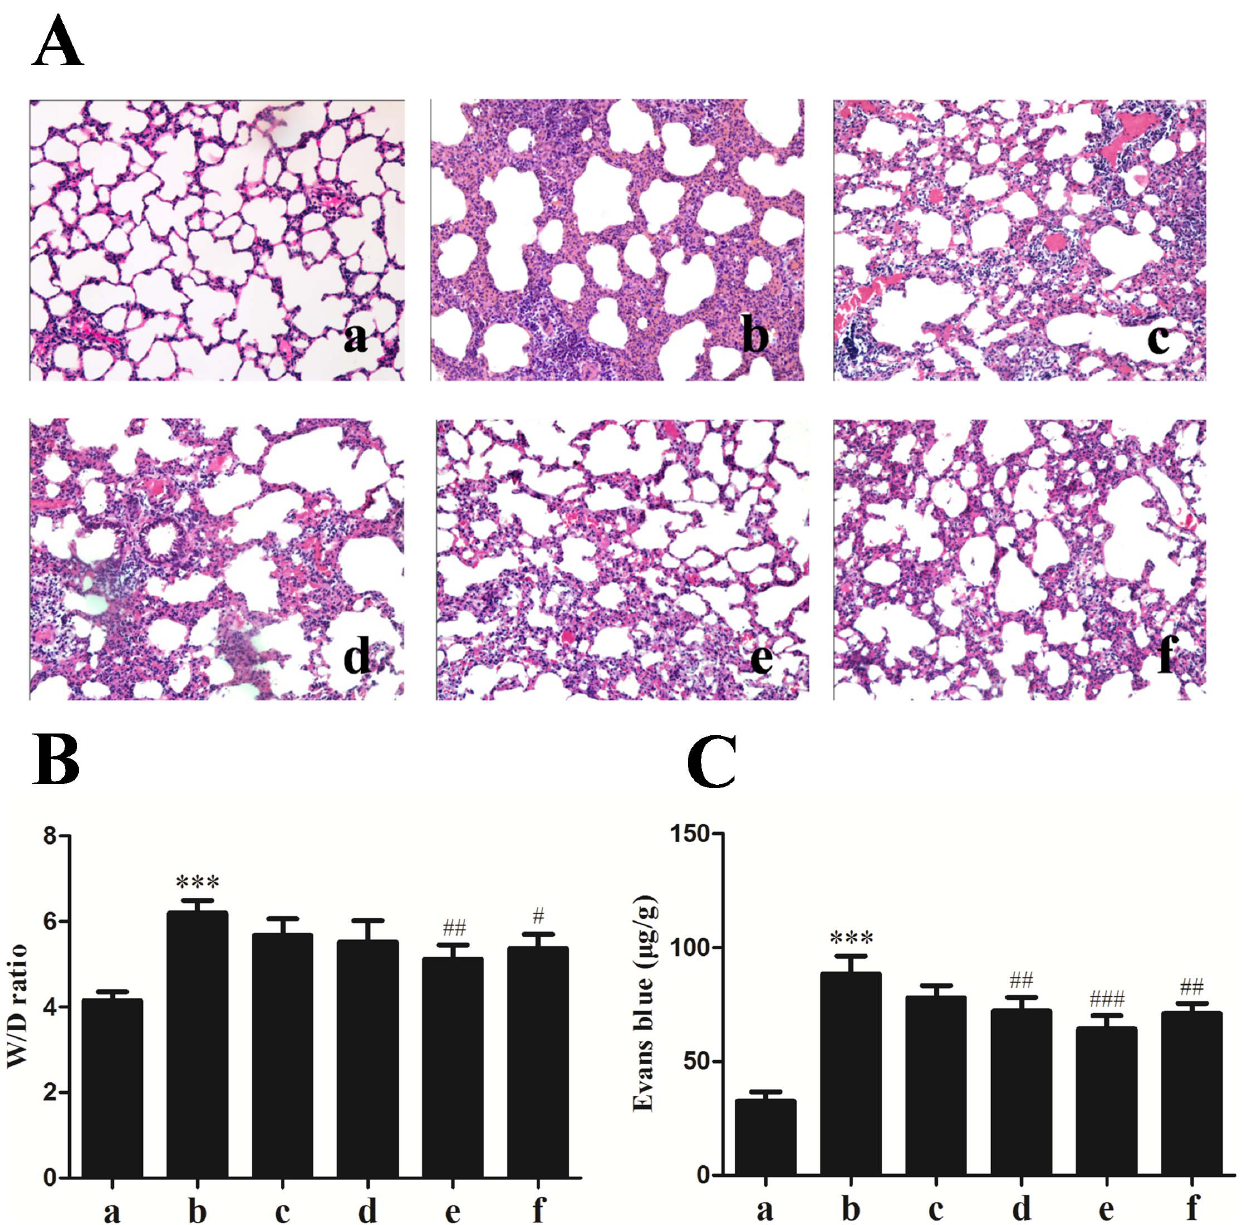
Figure 1. Effects of calcitriol on seawater aspiration-induced lung histopathologic changes (A), wet/dry weight ratios (B) and Evans blue leakage (C). Histopathologic, W/D ratio and Evans blue leakage examination of the lung tissues were performed at 4 h after seawater aspiration. (a) normal group; (b) seawater group; (c)–(e) 1 m g/kg, 5 m g/kg and 25 m g/kg calcitriol groups; (f) dexamethasone group. n=8, ***P , 0.001 versus group a, # P , 0.05, ## P , 0.01, ### P , 0.001 versus group b. Histopathologic changes showed pulmonary edema, infiltration of inflammatory cells, hemorrhage and alveolar distortion in seawater group. In calcitriol group, lung injury was significantly alleviated compared with seawater group and dose dependence was observed. Dexamethasone also alleviated lung damage compared with seawater group, but no significant difference compared with 25 m g/kg calcitriol group. (Hematoxylin-eosin stain, 20 6 ).